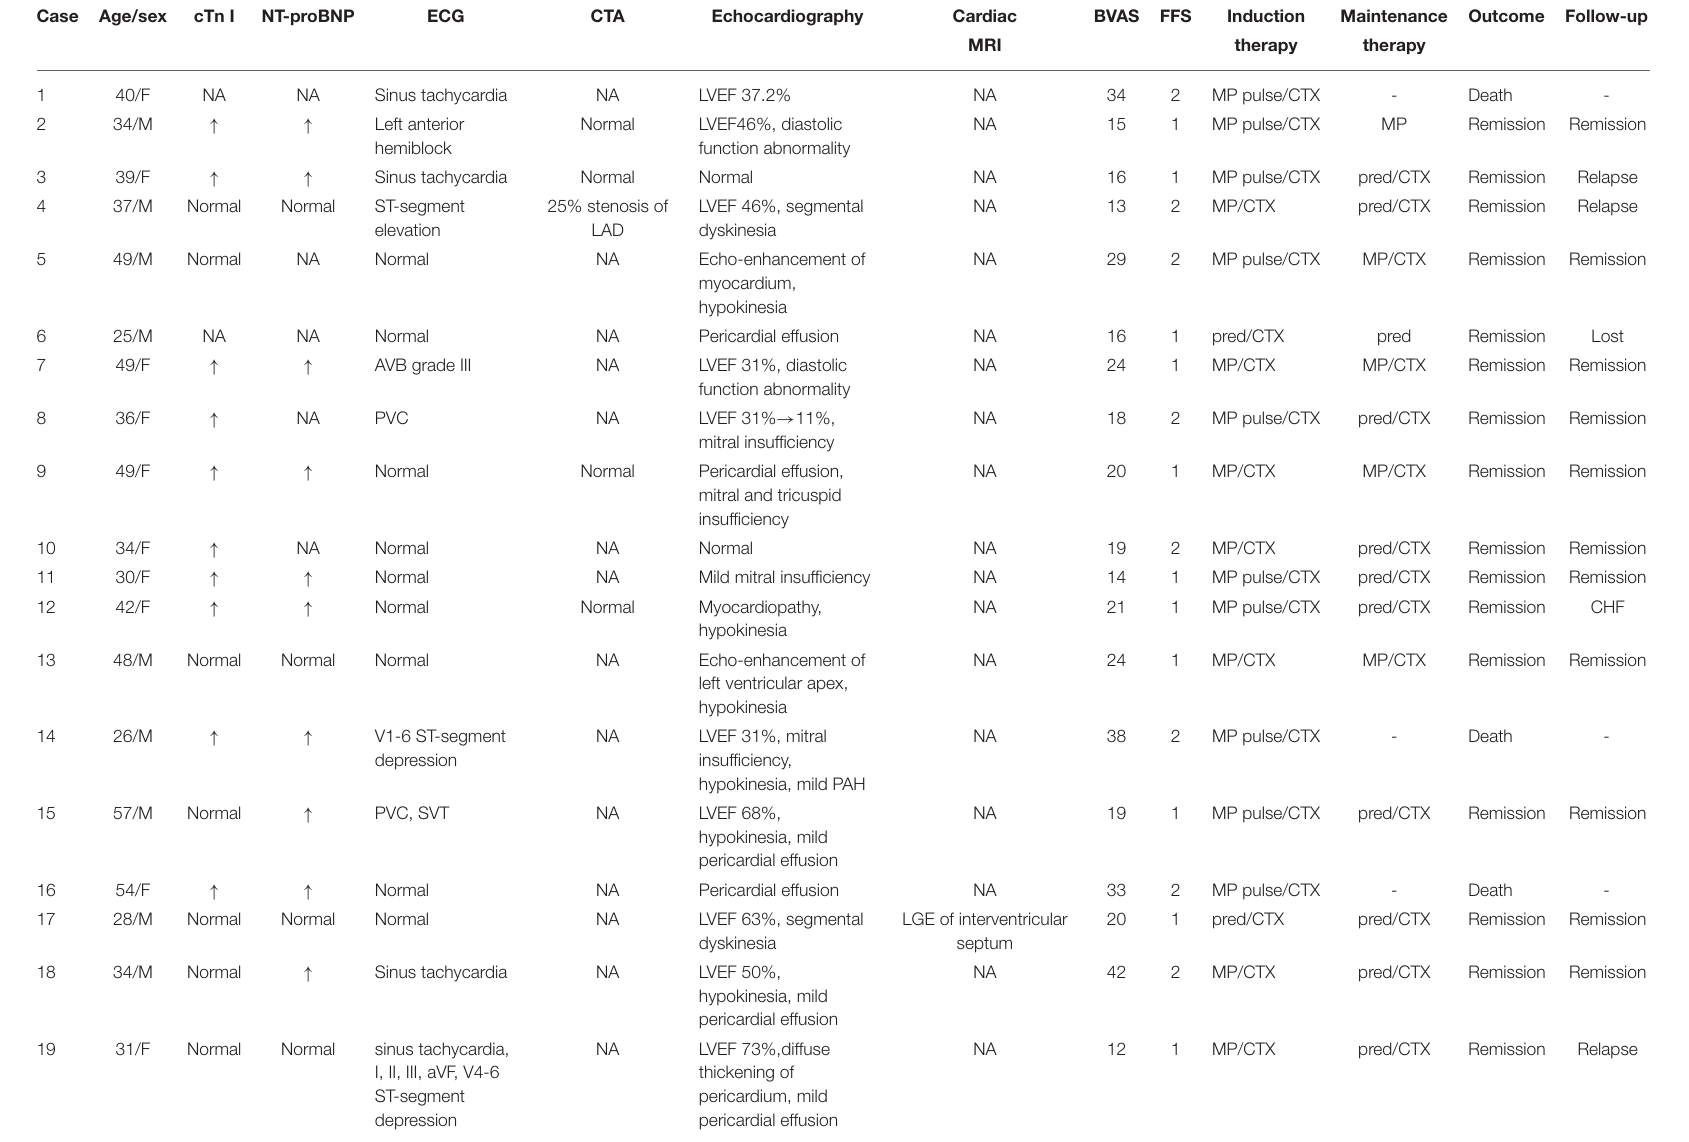
TABLE 2 | Cardiac findings, treatment, outcome and follow-up of 23 patients with